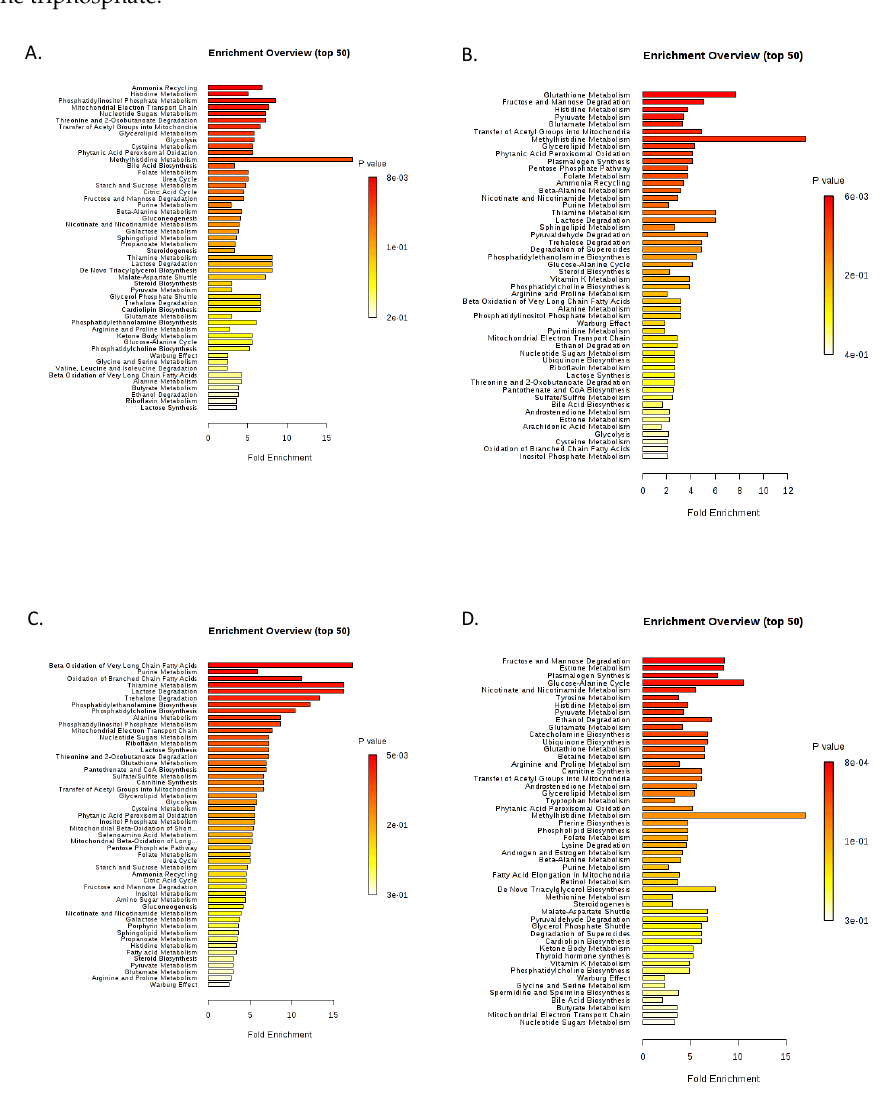
taking into account the maximum absolute log2fold values when a metabolite was found in both datasets. Data represent log2fold change, p < 0.05. Figure 3: Excessive metabolic dysregulation is present in myeloid cells of MDS patients. Metabolite set enrichment analysis (MSEA) was carried out by MetaboAnalyst (v4.0). Enriched pathways were ranked by significance (see color scale) calculated by the MetPa method implemented in MetaboAnalyst (v4.0). (A) MDS vs. control metabolome; (B) G2 vs. control metabolome; (C) G1 vs. control metabolome; (D) G1 vs. G2 metabolome. G1: Differentiating myeloid lineage cells isolated from MDS BM aspirates containing <5% blasts, G2: